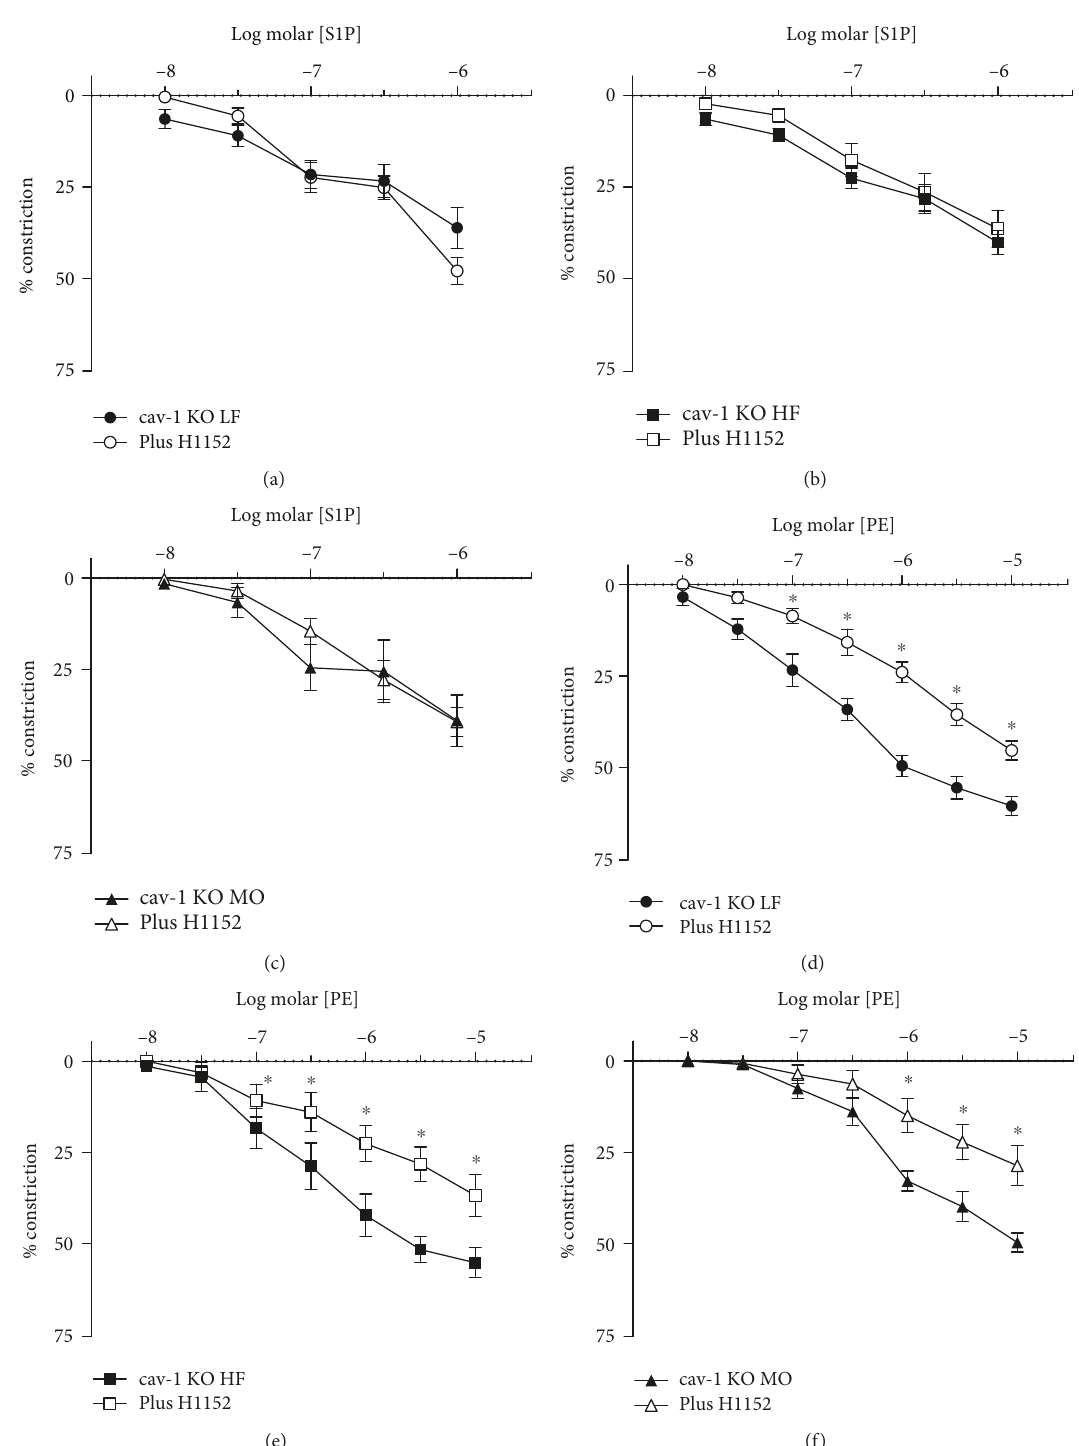
Figure 5: Constriction of gracilis arteries from cav-1 KO mice on LF ((a, d), n = 5 per group), HF ((b, e), n = 5 per group), and MO ((c, f), n = 6 per group) diets to S1P (a-c) or PE (d-f) before and after inhibition of rho kinase with H1152 (1 μ M). Mean ± SEM , ∗ p < 0 05 vs. without H1152. Two-way repeated-measures ANOVA followed by Sidak ’ s multiple comparison